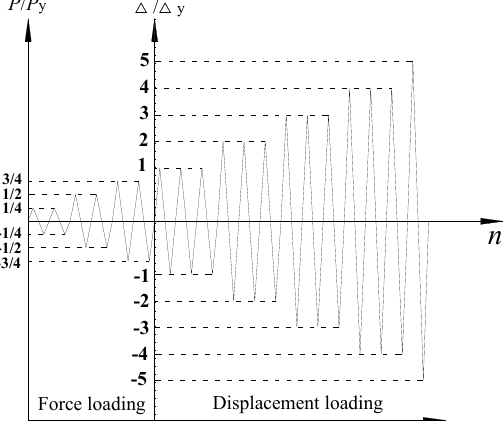
Figure 3. Loading device. ( a ) Design drawing of test loading device; ( b ) The test site.